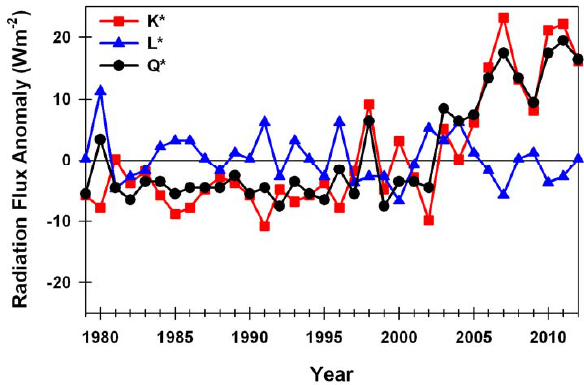
Figure 9. Time series of NARR mean June through September (JJAS) net shortwave, net Fig. 9. Time series of NARR mean June through September (JJAS) longwave and net all-wave (Q*) radiation anomalies (Wm -2 ) in the Canadian Arctic Archipelago, 1979-2012. Anomalies calculated with respect to the 1981-2010 climatology. net shortwave ( K ∗ ), net longwave ( L ∗ ) and net all-wave ( Q ∗ ) ra- diation anomalies (Wm − 2 ) in the Canadian Arctic Archipelago, 1979–2012. Anomalies calculated with respect to the 1981–2010